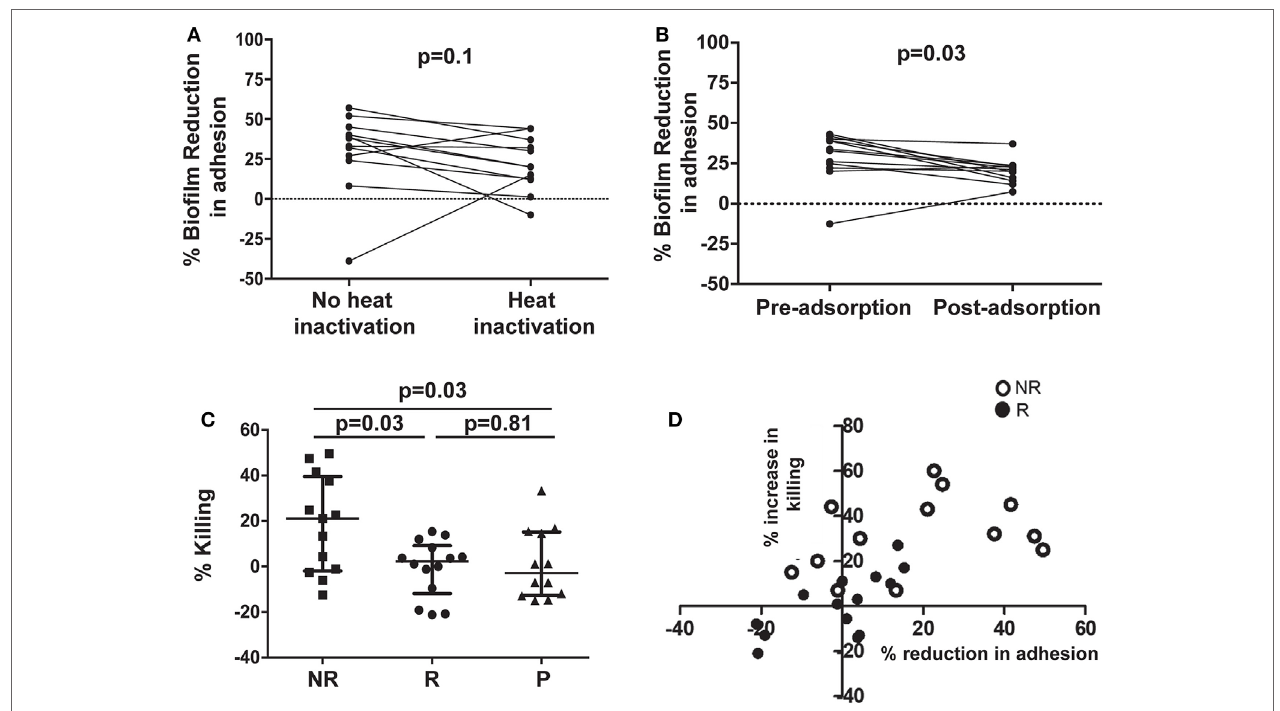
FigUre 5 | Assessment of the role of antibodies in affecting virulence, and evaluation of opsonophagocytic killing (OPK) of Candida albicans germ tubes in the presence of patient sera. Heat treatment of post-vaccination sera from non-recurrent (NR) patients does not significantly reduce its biofilm-inhibitory activity, compared with paired untreated sera (a) . Adsorption of antibodies in post-vaccination sera from NR patients with C. albicans germ tubes significantly ( p = 0.03) abolishes the biofilm-inhibitory activity of the sera, when compared with paired adsorbed pre-vaccination sera (B) . Only post-vaccination sera from NR patients significantly ( p = 0.03) enhance OPK and killing of C. albicans germ tubes by human neutrophils, compared with post-vaccination sera from R or P patients (c) . A comparison between percent increase in OPK activity and percent reduction in adhesion, in post-vaccination sera from NR and R patients, resulted in significant correlation within the respective subject sera (D) . Each open circle represents individual NR sera, which displayed both an overall greater reduction in adhesion and increase in neutrophil killing. Solid circles denote the individual R patients those who compared with the NR patients, show a smaller % decrease in adhesion as well as neutrophil killing. Negative values on the graph represent % increase in adhesion or % decrease in neutrophil